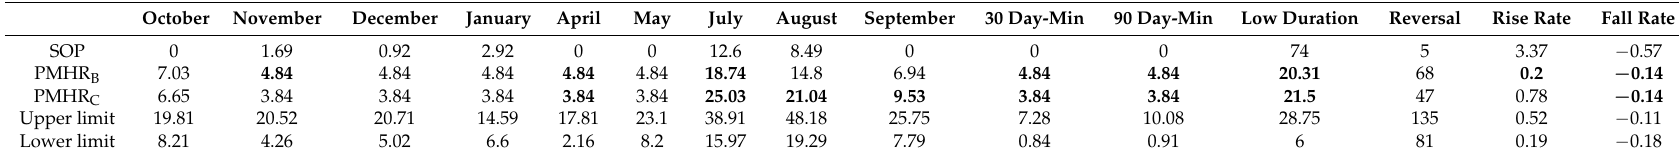
Table 6. Comparison of indicator analysis of standard operating policy (SOP) and the piecewise-linear multi-objective hedging rule